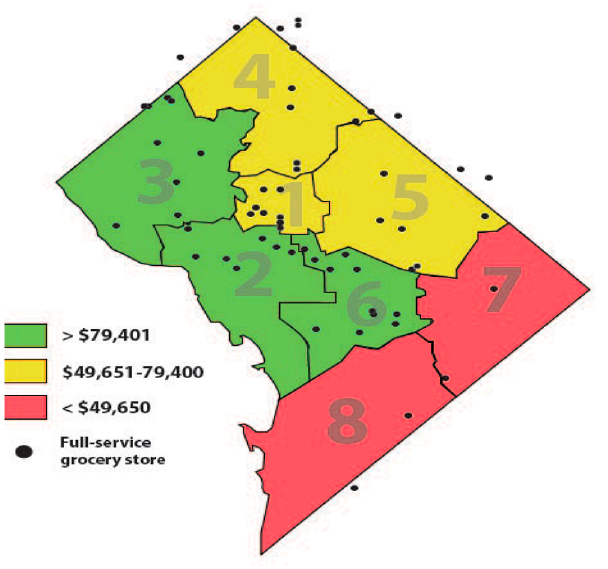
Figure 1. Washington DC median annual household incomes by eight Wards and grocery store